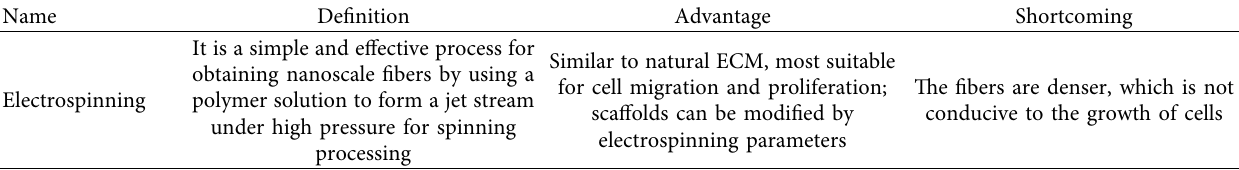
Table 2: Common methods for preparation of geotechnical support.